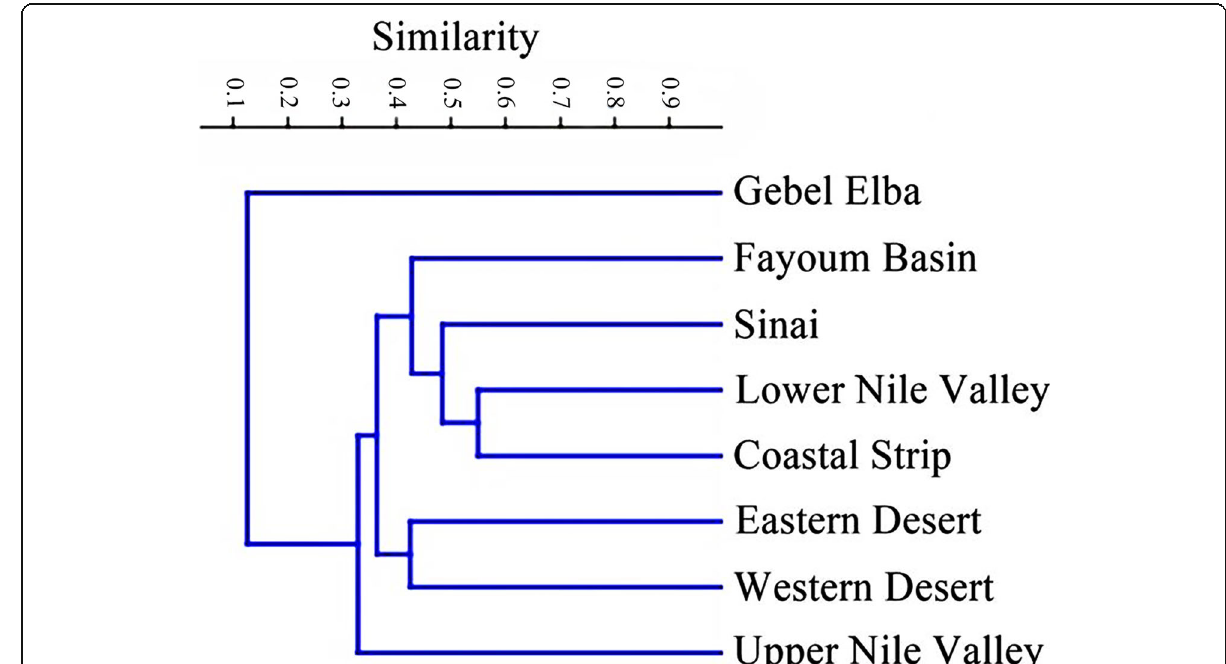
Fig. 2 Dendrogram of the similarity in species composition of the ecological